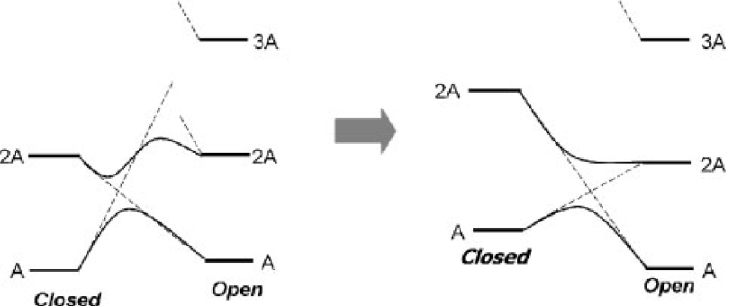
Figure 7. PES profile change from normal-type (left, with barrier on 2A surface) to inverse-type (right, without barrier on 2A